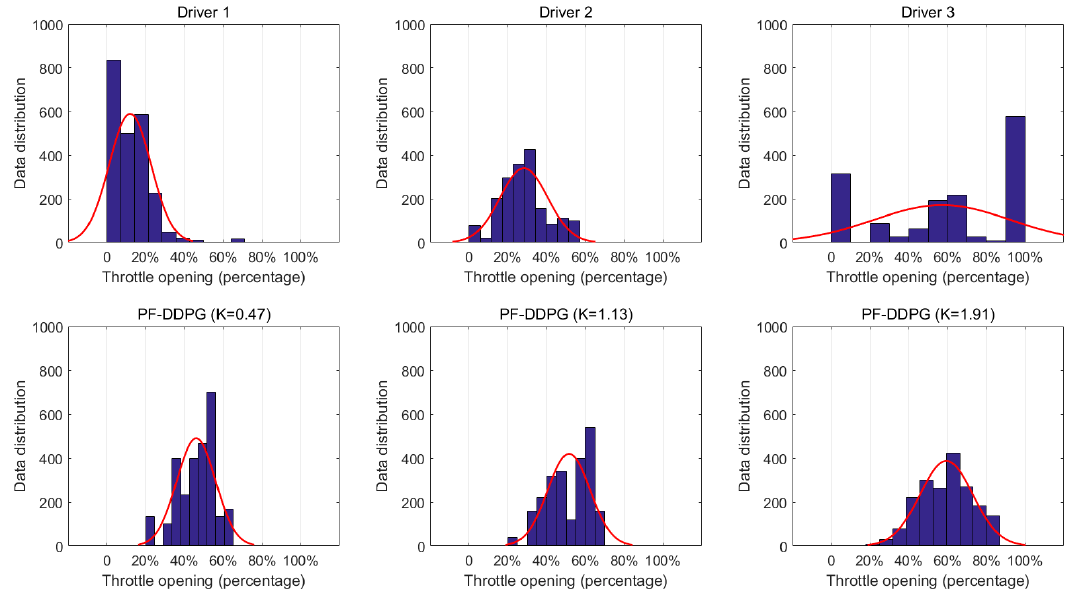
Figure 10. PF-DDPG acceleration distribution compared with drivers.